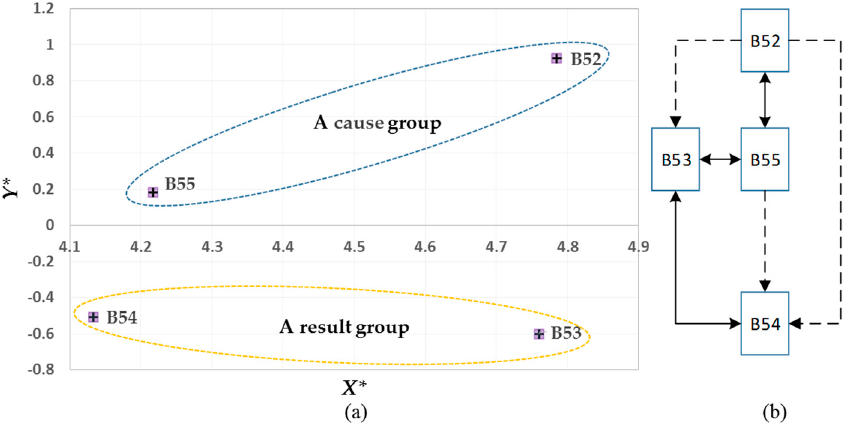
Figure 10. Cause and effect diagrams for the economic non-market. ( a ) The causal attributes and ( b ) significant relationships of sub-criteria affiliated with Z5.